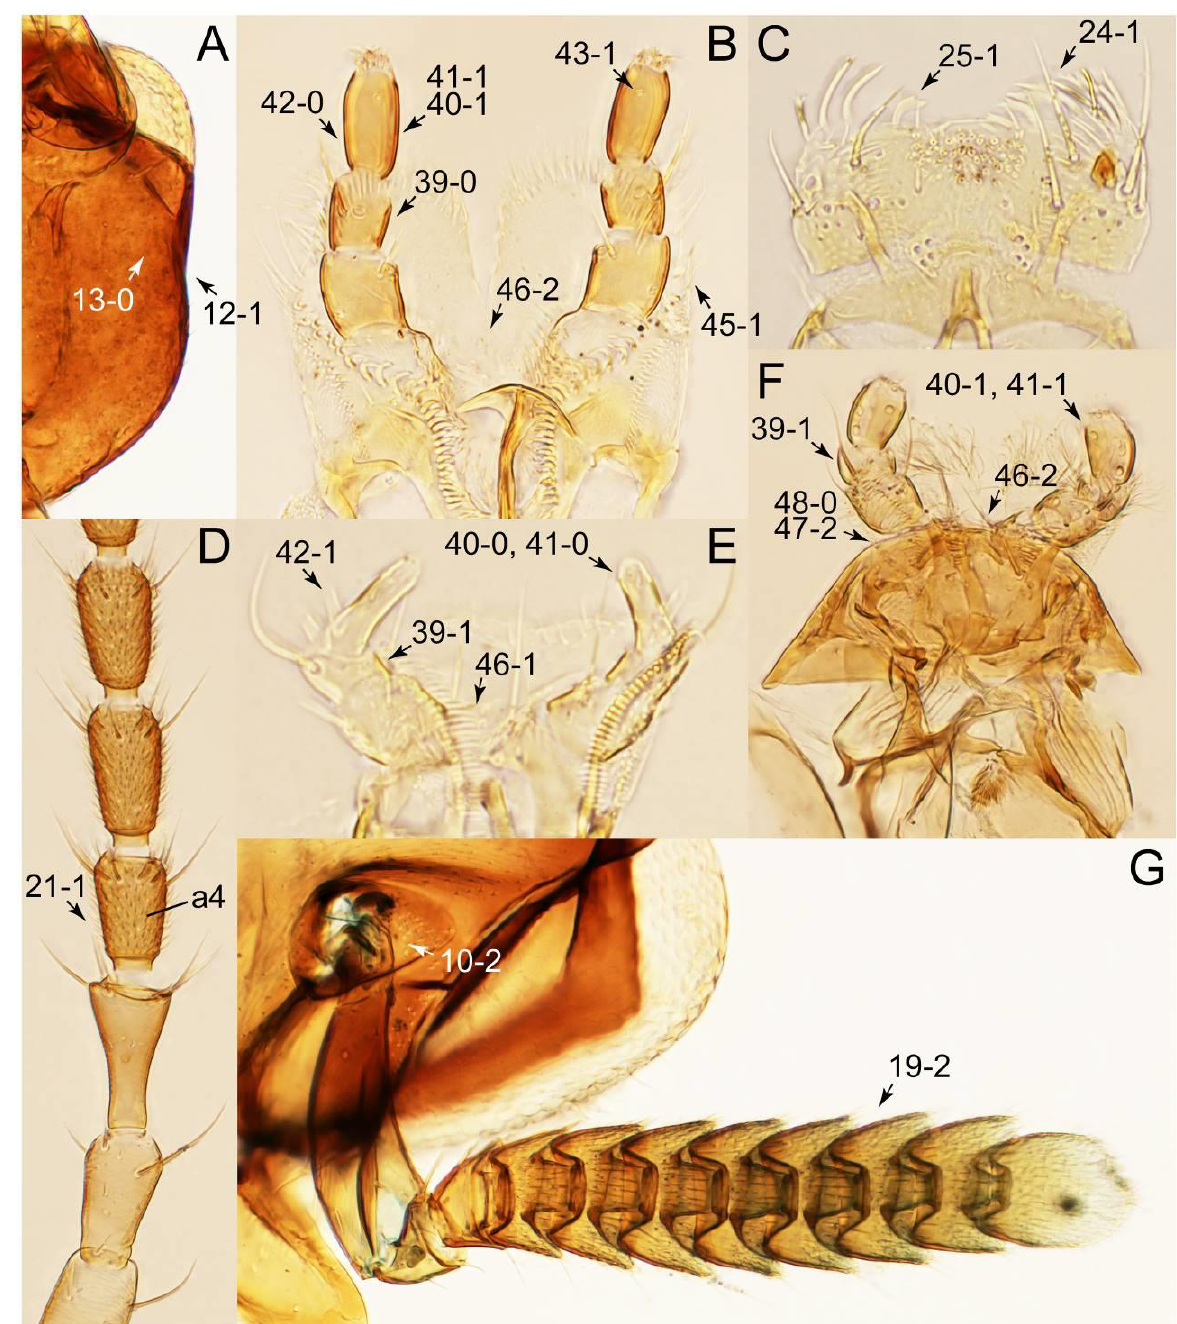
Figure 26. Photographs of body parts of Vatesini, enlarged. ( A ) head of Coproporus colchicus , ventral view. ( B ) labium of Cilea limbifera (Motschulsky), ventral view. ( C ) labrum of Coproporus colchicus , dorsal view. ( D ) basal half of left antenna of Cilea limbifera , ventral view. ( E ) labium of Mimocyptus sp., ventral view. ( F ) labium and mentum of Coproporus laevis , dorsal view. ( G ) antennal insertion and left antenna of Vatesus praedatorius , dorsal view. Abbreviation: a4, antennomere 4. Characters and character states (format X-X) are indicated on each